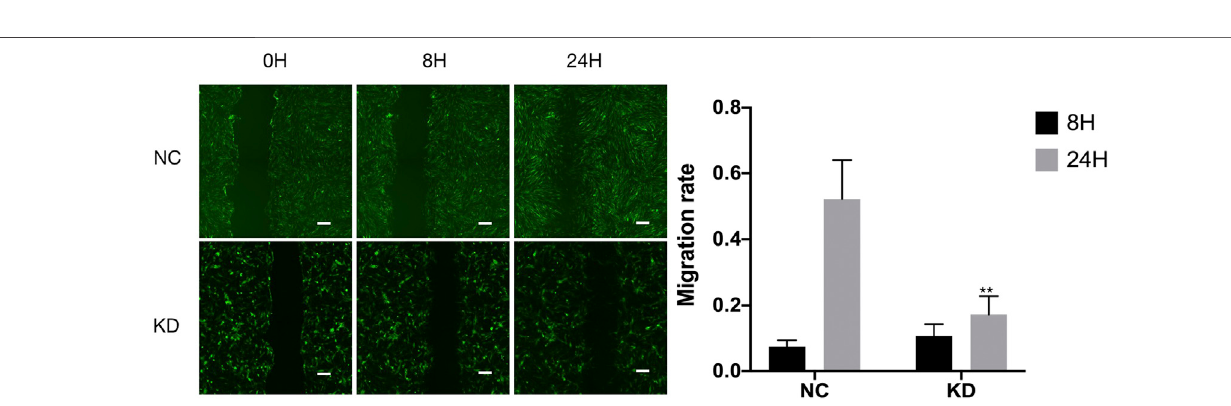
Frontiers in Molecular Biosciences |